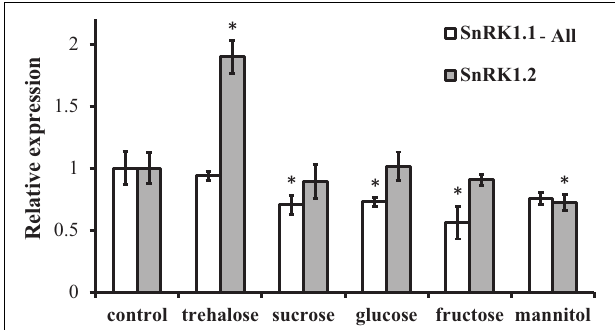
FIGURE 3 | RNA levels of SnRK1.1 and SnRK1.2 in sugar-treated seedlings. Wildtype seedlings were grown for 9 days and then treated with no sugar (control), 1% trehalose, 1.5% sucrose, 1.5% fructose, or 3% mannitol. SnRK1.1 and SnRK1.2 expression was measured with real-time PCR and was normalized to SnRK1.1 control and SnRK1.2 control levels, respectively, which are set to 1. SnRK1.1-All primers amplify all SnRK1.1 cDNAs, including those that encode SnRK1.1 and SnRK1.1T proteins. Means of triplicate reactions ± SD are presented. ∗ p -value ≤ 0.05 when compared to the control.